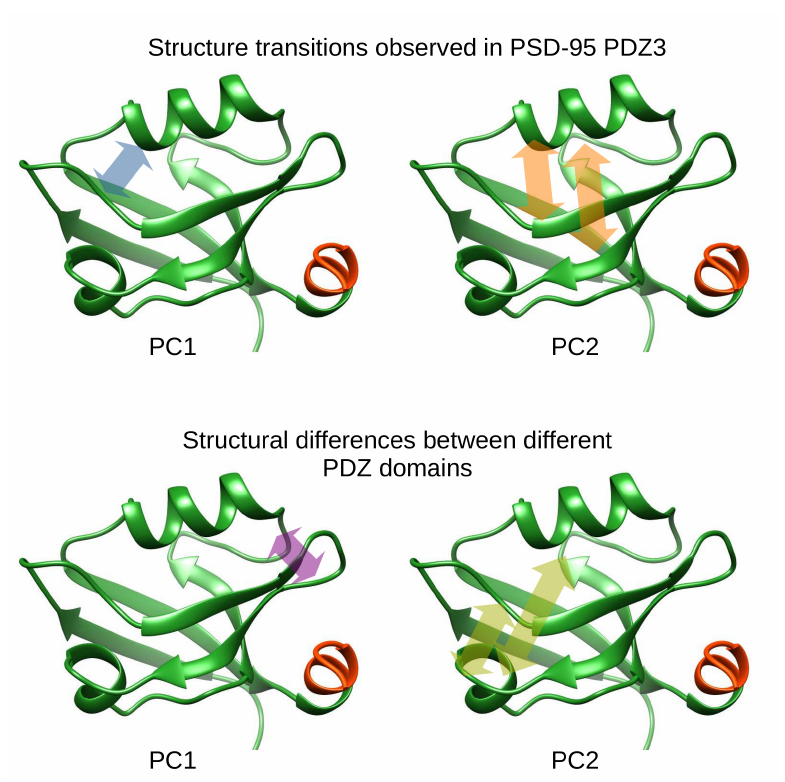
Figure 8. Summary of the most important structural rearrangements/differences within PDZ domains identified in this study. For the structure transitions in PSD-95 PDZ3, PC1 and PC2 refer to the principal components shown in Figure 3 and for the structural differences between domains, PC1 and PC2 refer to the PCA shown in Figure